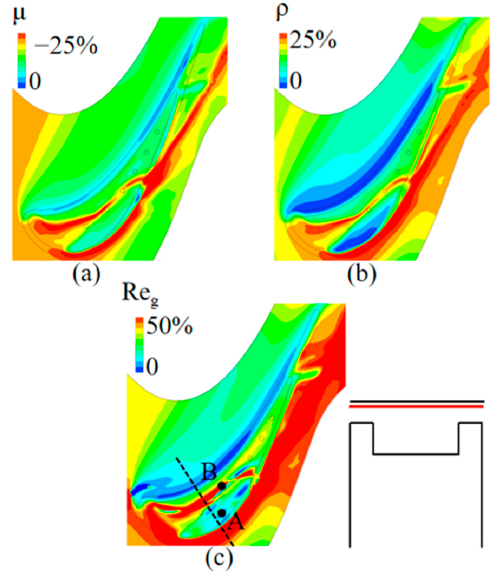
Figure 6. Percentage change in fluid properties near the squealer casing surface (location indicated by the red line, 1% Cz off the casing): ( a ) dynamic viscosity, ( b ) density, ( c ) percentage difference distribution of Re g .